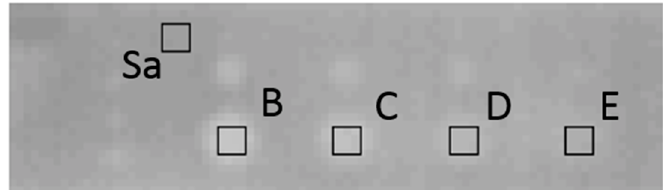
Figure 2. Thermal image of acrylic glass test sample: 450th frame after a light pulse.